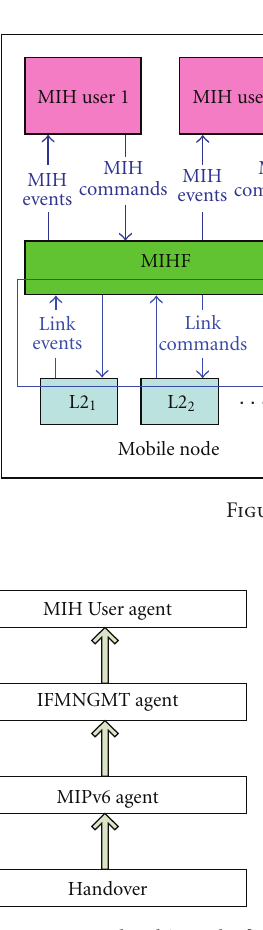
Figure 2: MIH User class hierarchy